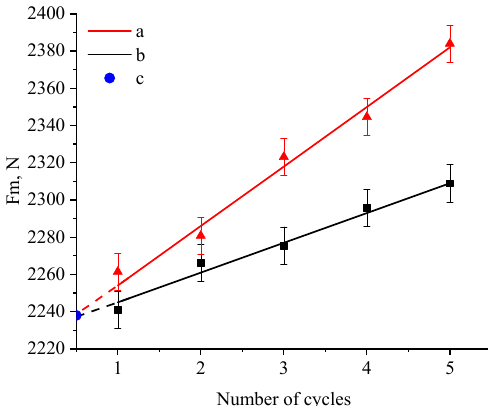
Figure 18. The dependences of the value of the tensile strength of samples on the number of coating cycles on the surface of the ABE wires: (a) ABE wires treated by sequential immersion in tetraethoxysilane and ammonia; (b) ABE wires treated by immersion in SiO 2 nanoparticles sol; (c) uncoated wires (control sample).